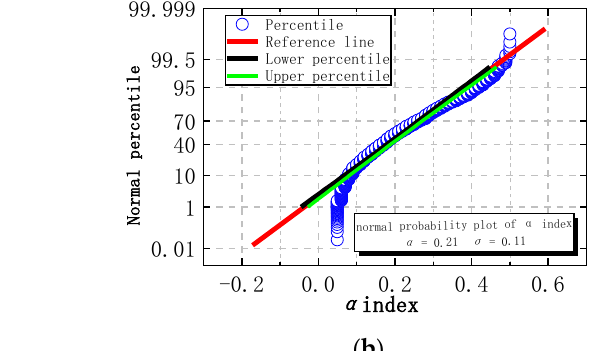
Figure 6. Sample distribution of wind profile index: ( a ) α histogram of exponential frequency distribution; ( b ) normal probability plot of the α index.